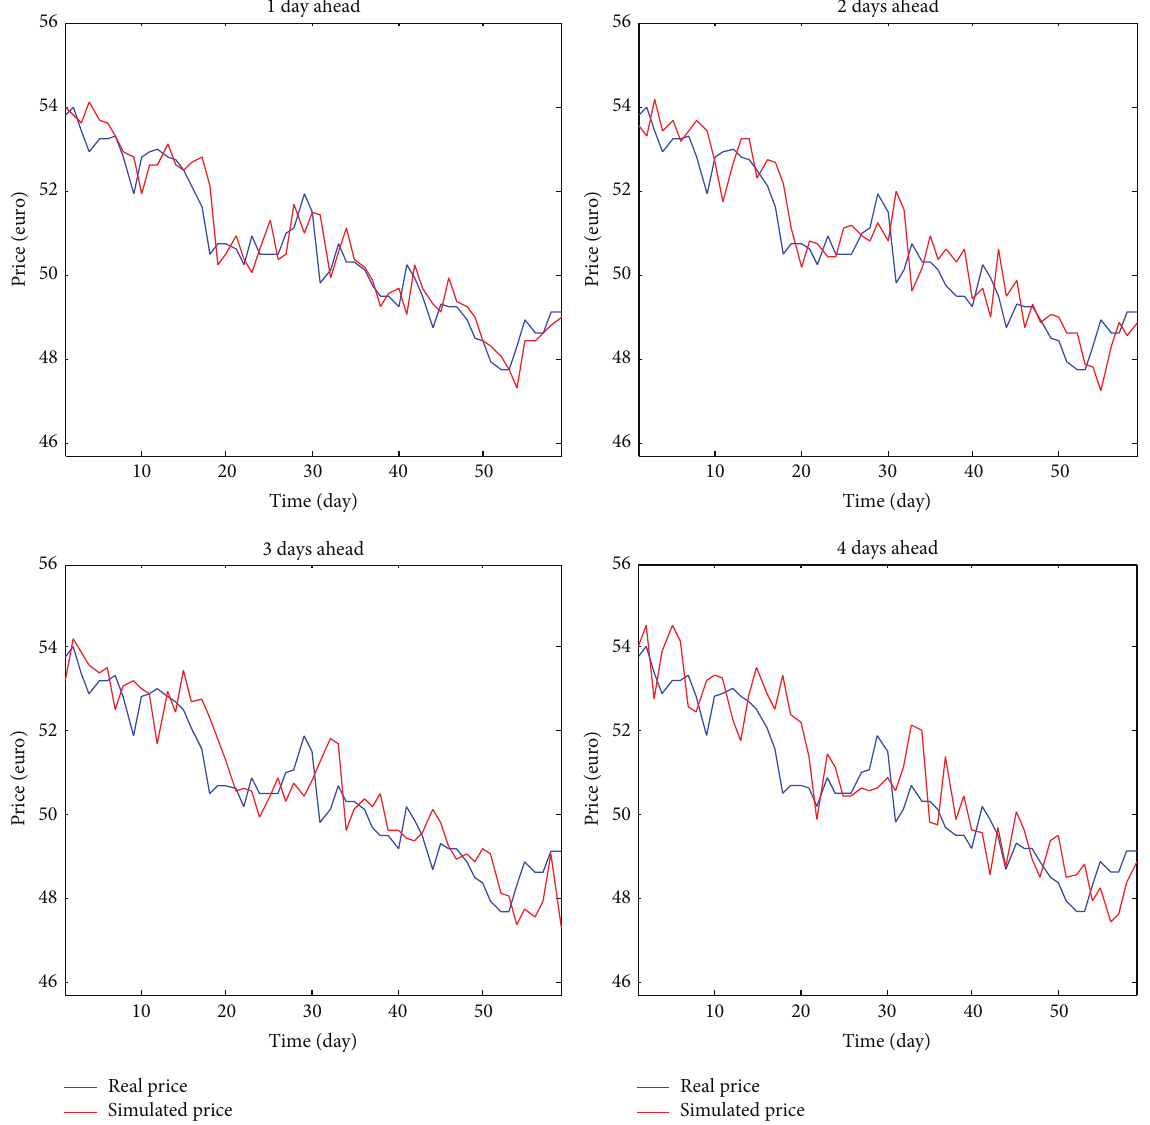
Figure 1: In this figure, we present the price curves obtained by simulating the peak contract of June 2012 using (71) with the specification above stated. The graphics in the figure present forecasts of the contract value at 1,2,3 , and 4 days ahead.